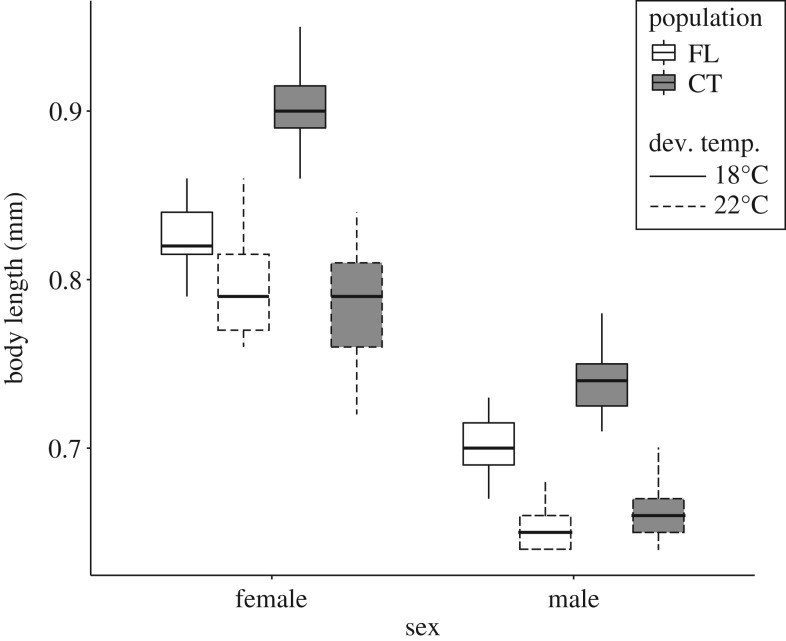
A box-and-whisker plot showing body size data for the various groups. Measurements are grouped by sex. The Florida (FL) population is shown in white, and the Connecticut (CT) population in grey. The two developmental temperature groups (18 and 22°C) are indicated with solid and dashed lines, respectively.